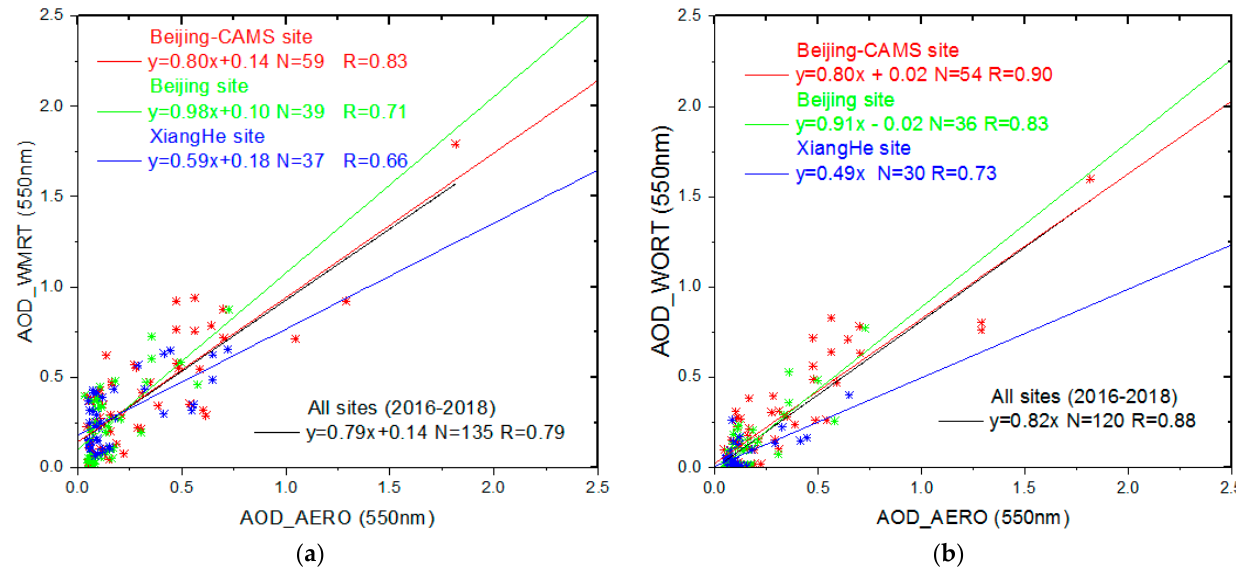
Figure 12. A comparison between ground-measured AOD_AERO and GF-1/WFV retrieved 550 nm AODs from 2016 to 2018. ( a ) AOD_WMRT and ( b ) AOD_WORT (red, green, blue, and black symbols represent Beijing-CAMS, Beijing, XiangHe, and all sites, respectively).